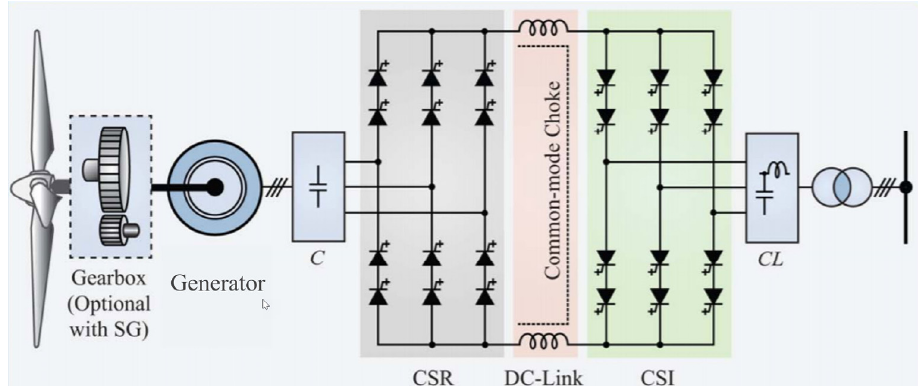
Figure 15. Grid connected wind turbine system with a back-to-back current source converter with multilevel based control.